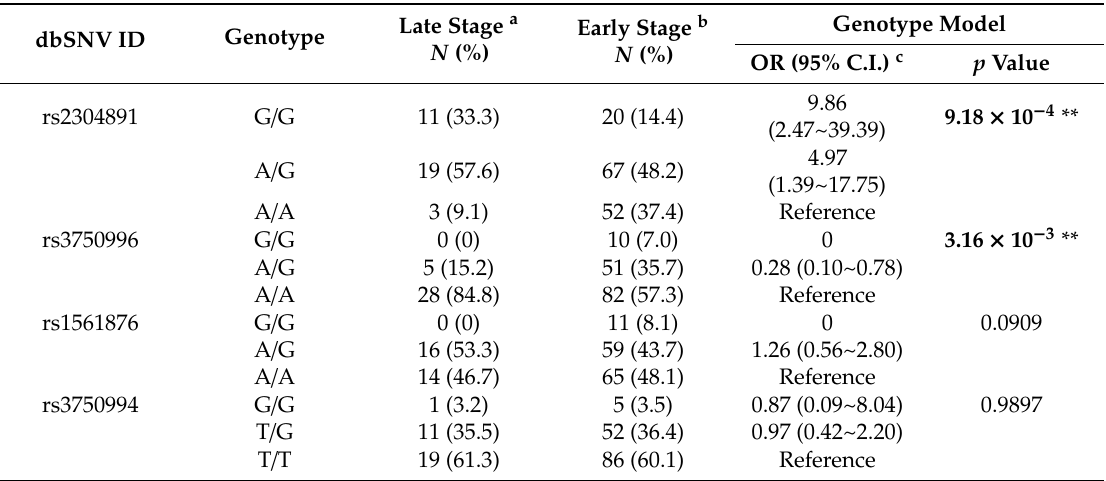
Table 4. Association analysis between germline genetic polymorphisms of STIM1 and TNM stage in estrogen receptor (ER) positive breast cancer patients.